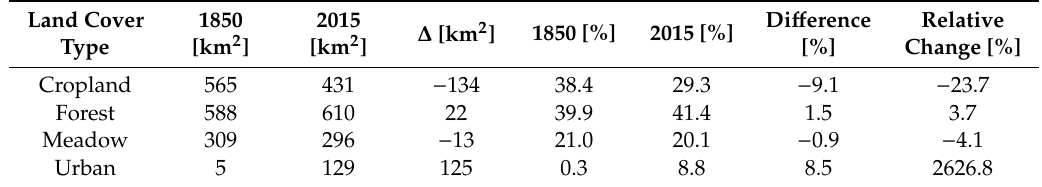
Table 4. Overall land cover change in the Main catchment.